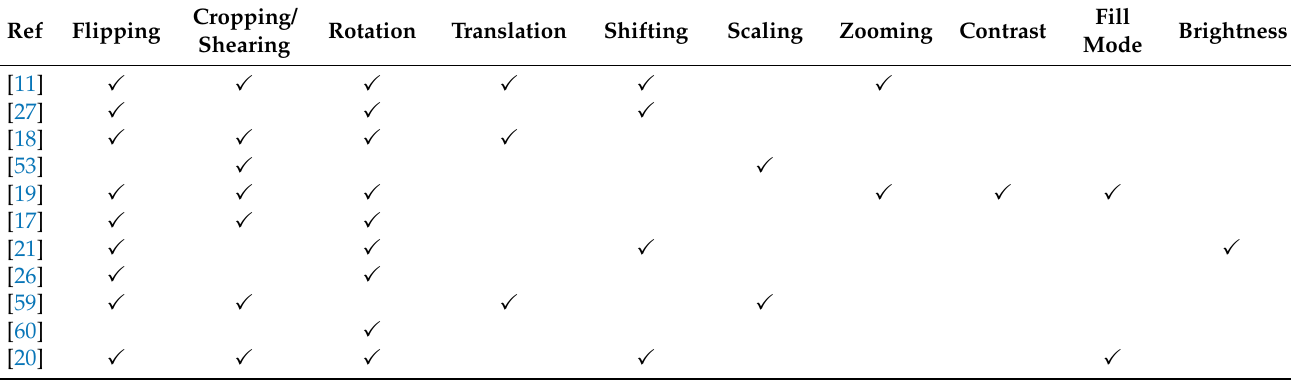
Table 3. Comparison of data augmentation.